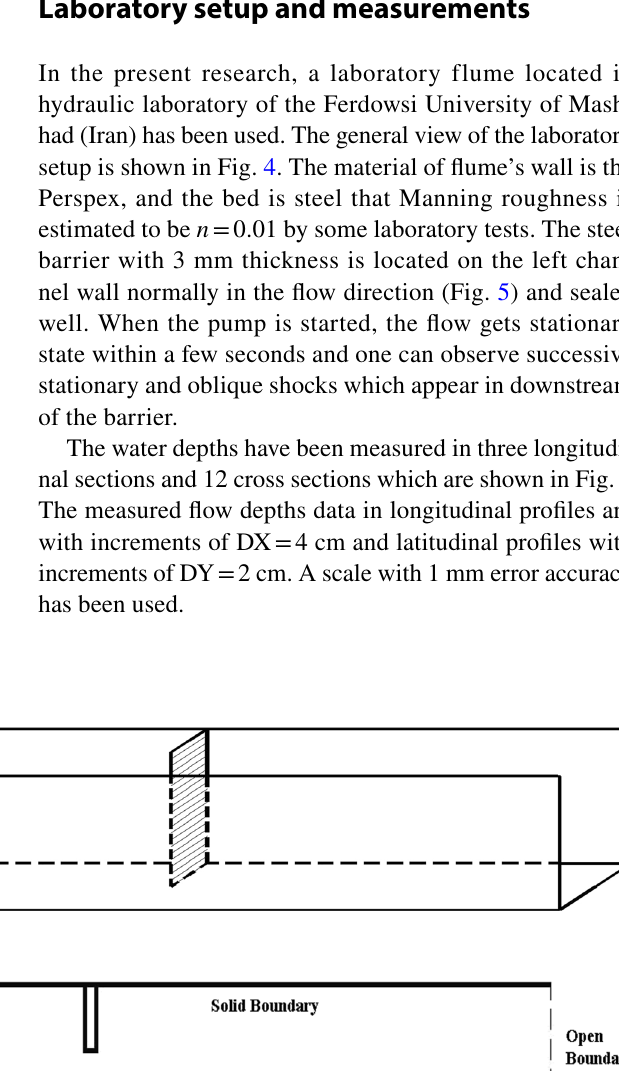
Fig. 2 The boundary conditions in numerical